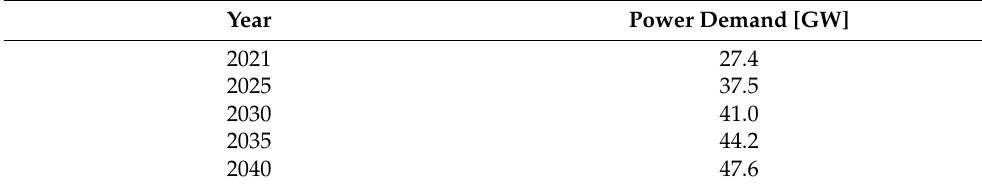
Table 3. Power demand in the CM scenario until